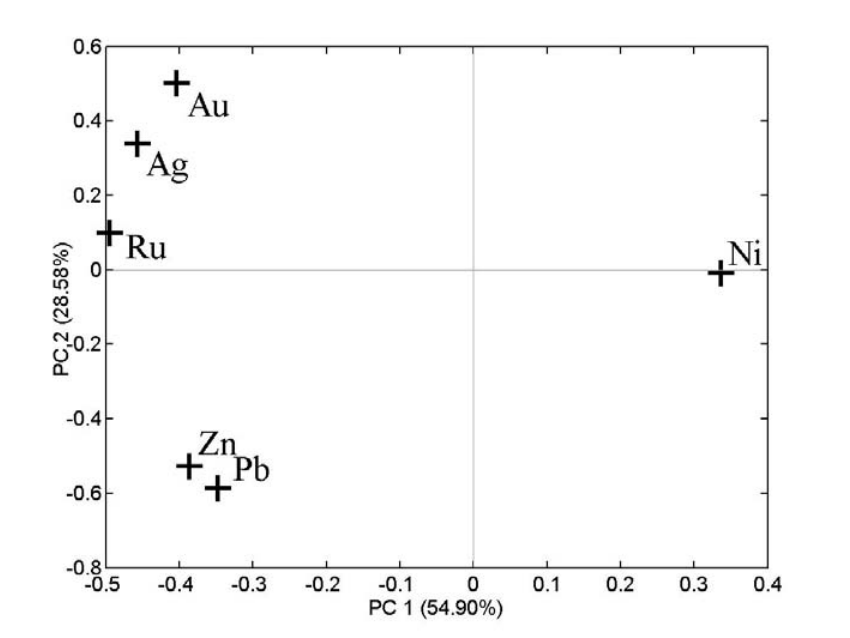
Figure 3. Loading plot of the PCA analysis performed on the responses of the 6-electrode array to different aqueous solutions.